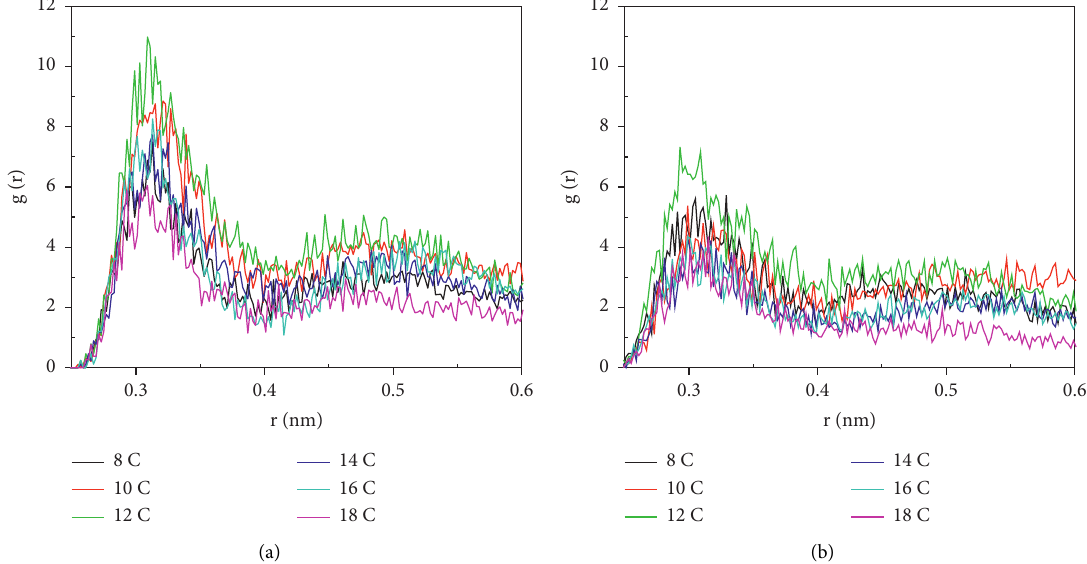
Figure 8: (a) The RDF of the oxygen atoms in the hydroxyl groups on the coal surface and the oxygen atoms in the surfactants; (b) the RDF of the oxygen atoms in the ketone groups on the coal surface and the oxygen atoms in the surfactants.